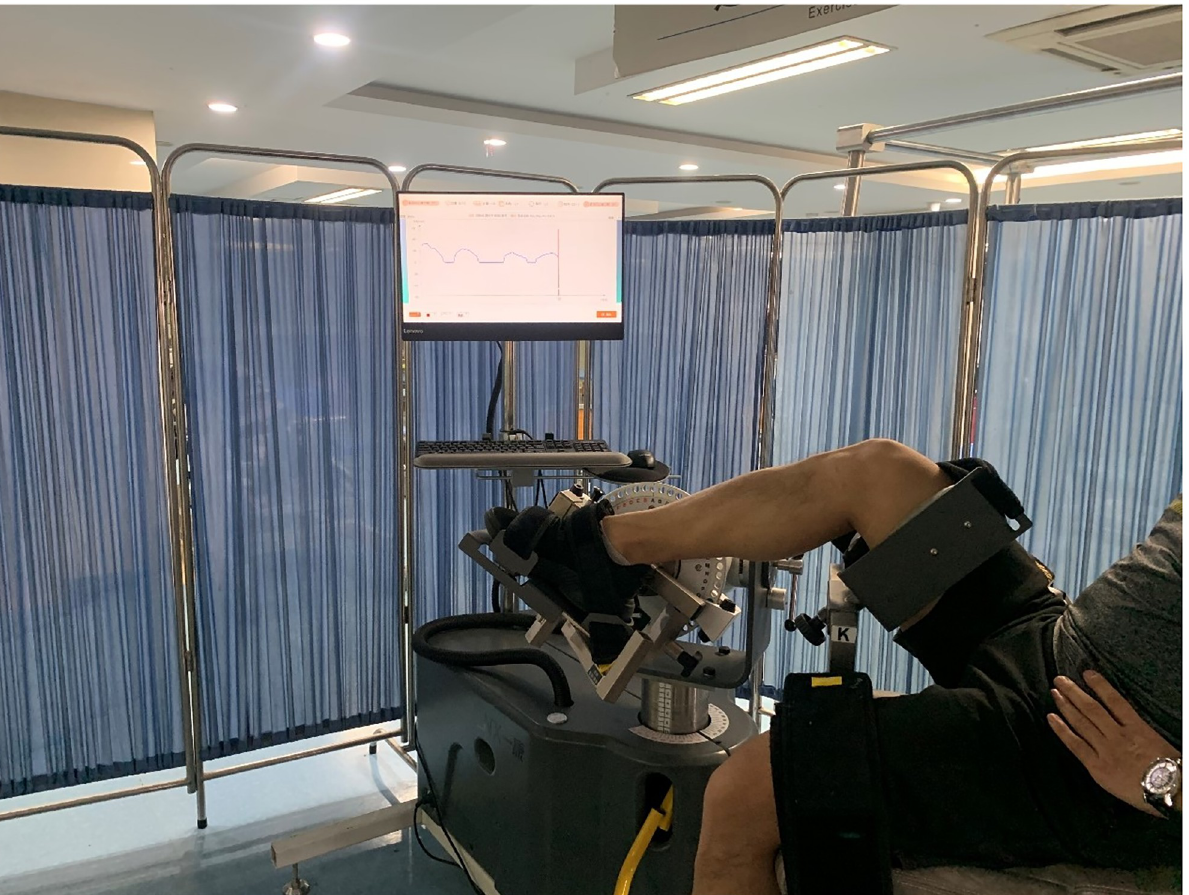
Fig 3. Isokinetic strength